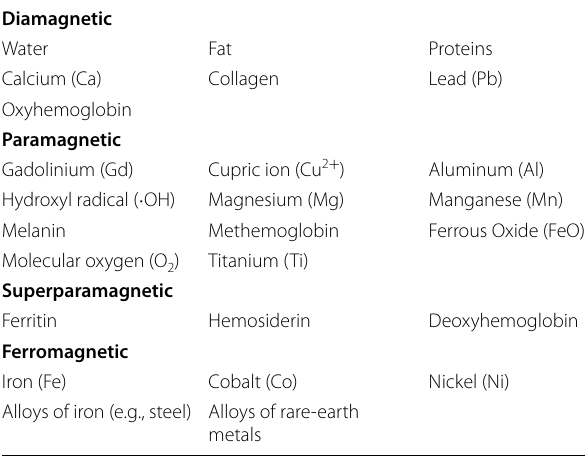
Table 1 Principal endogenous and exogenous substances, listed according to their magnetic